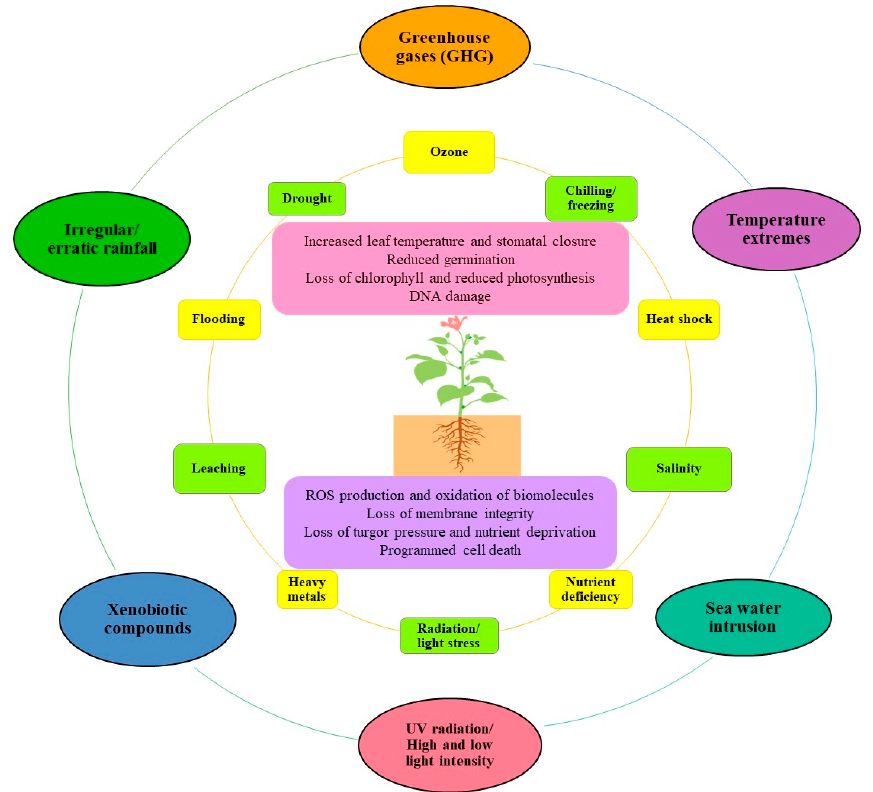
Figure 1. Climate change intensifies the magnitude of abiotic stresses that severely affect plant growth and physiological activities. Various abiotic factors modified by environmental conditions (outer circle) leads to abiotic stresses (the inner circle) that hamper plant physiological and metabolic activities, biomolecules, cellular structure, growth, and productivity (rectangular innermost blocks). Table 1. Abiotic stresses triggered secondary stresses and their damaging effects on plant growth and activity. Abiotic